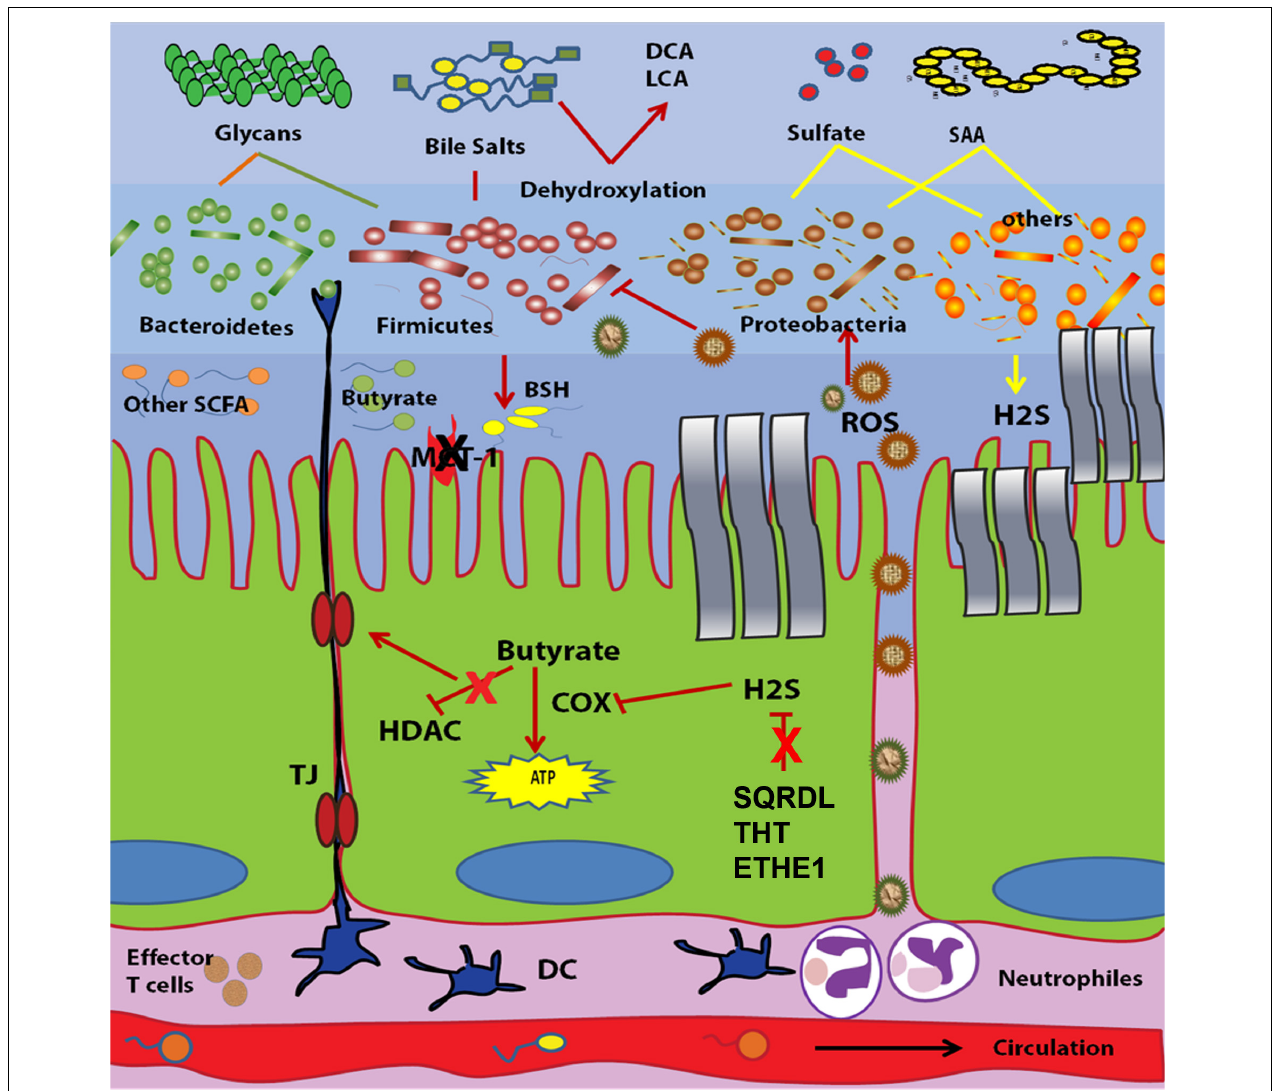
FIGURE 2 | Proposed Host-microbe metabolic dysfunctionalities in inflammatory bowel disease. The oxidative stress environment created by inflammation acts as a selective pressure. This pressure favors the microbes that are able to resist that stress such as Proteobacteria members but not Firmicutes members. This in turn leads to less short chain fatty acids (SCFAs) production, less bile salts hydrolases (BSHs) in association with higher H 2 S release. From the host side, impaired butyrate transport and oxidation, less mucin secretion, low tight junction (TJ) expression, and defective H 2 S detoxification are the major host metabolic perturbations associated with